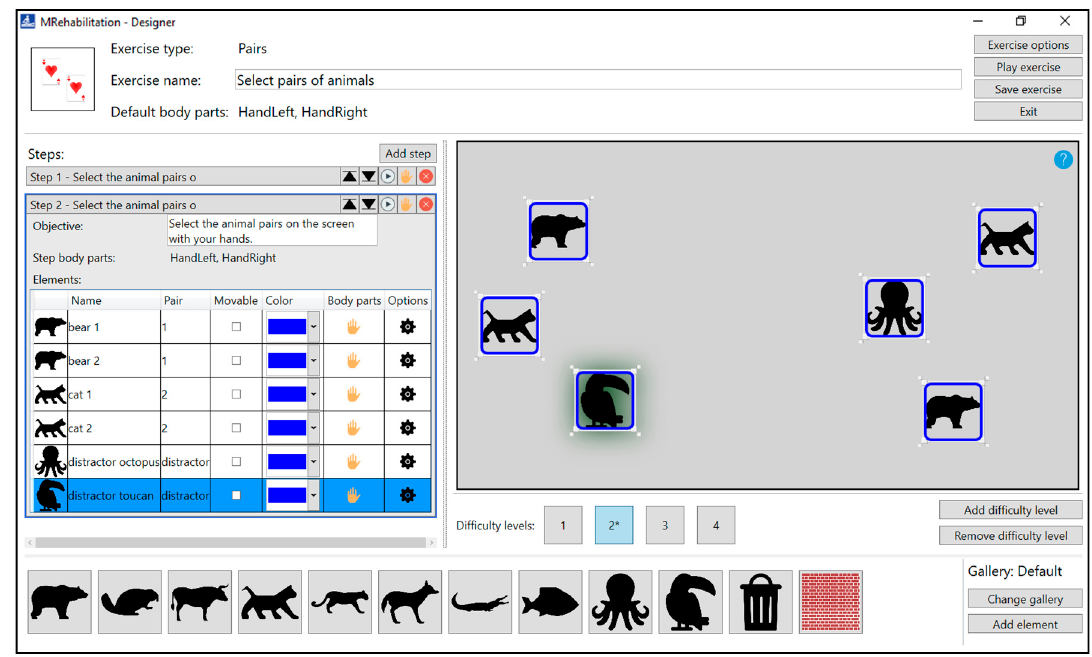
Figure 2. Exercise creation interface.